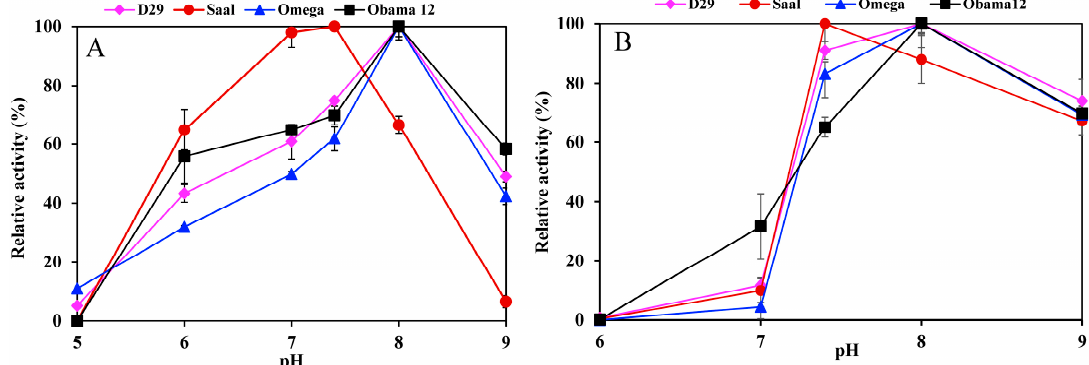
Figure 2. pH activity profile of LysB-His 6 enzymes in pH range 5–9 using 20 mM phosphate buffer (pH 5–7) and 20 mM Tris–HCl (pH 7.4–9) against: ( A ) 1 mM p NPB at 37 ° C (the 100% activity corresponded to 10, 9.77, 0.0524 and 0.0145 U/mg in case of p NPB for LysB-D29, –Omega, –Saal and –Obama12, respectively), ( B ) 0.33% Tween 80 at 30 ° C (the 100% activity corresponded to 42.1, 1.058, 7.11 and 4.49 kU/mg in case of Tween 80 for LysB-D29, –Omega, –Saal and –Obama12, respectively). Symbols: LysB-D29 ( ♦ ), LysB-Saal ( ● ), LysB-Omega ( ▲ ) and LysB-Obama12 ( ■ ). The experimental details are described in Section